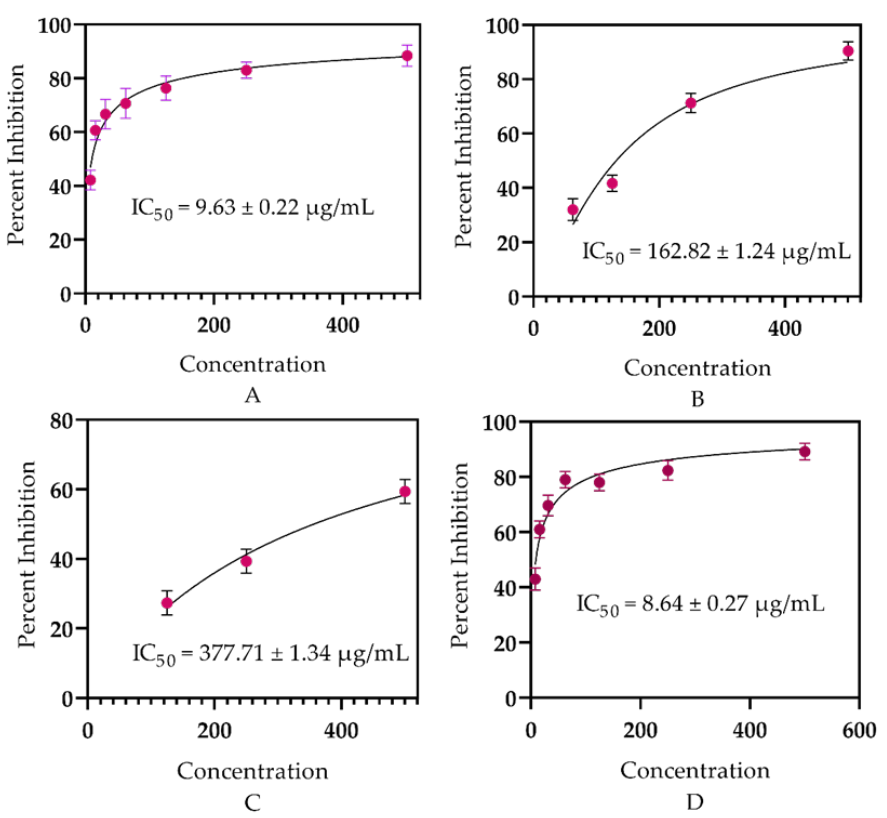
Figure 2. In vitro antidiabetic potential of ELEO: ( A ) α -glucosidase, ( B ) carbonic anhydrase-II, Figure 2. in vitro antidiabetic potential of ELEO: ( A ) α -glucosidase , ( B ) carbonic anhydrase-II, ( C ) ( C ) acarbose, ( D ) acarbose, ( D ) acetazolamide.